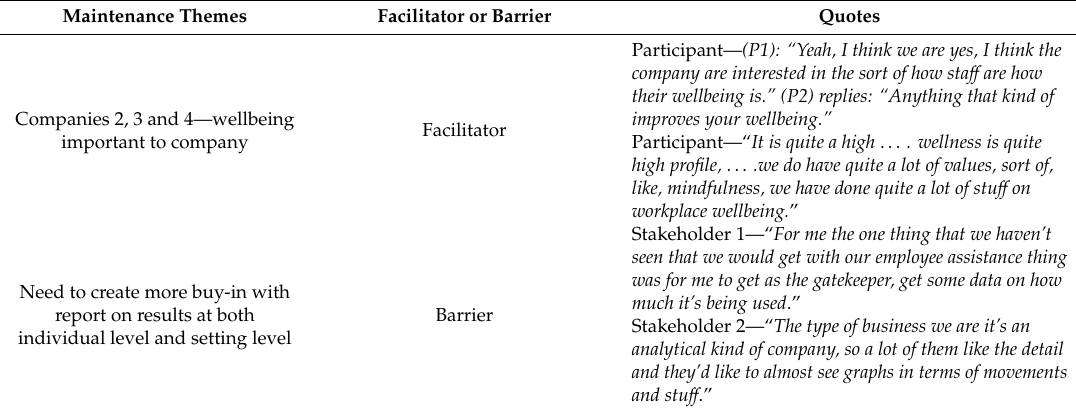
Table 11. Qualitative themes related to indicators of